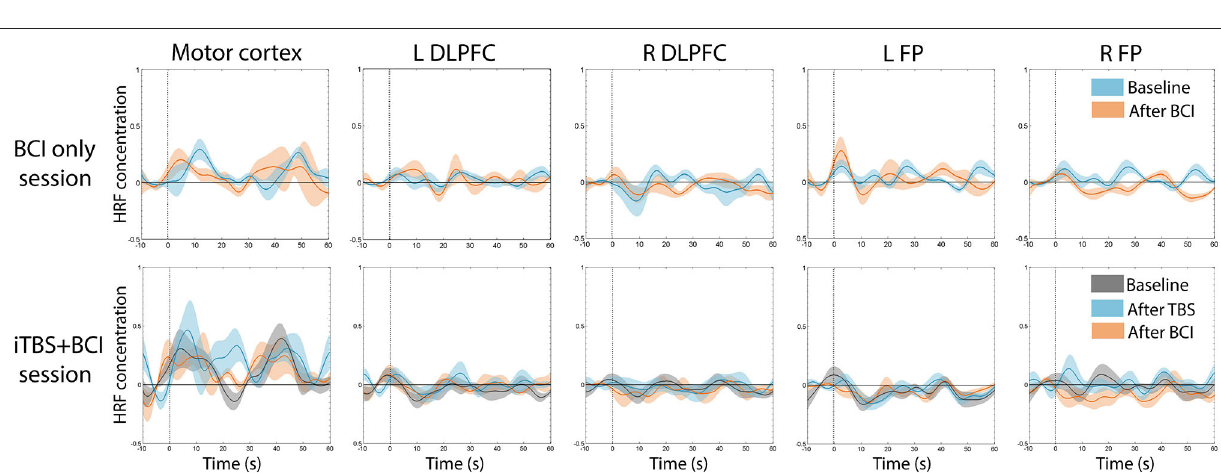
FIGURE 5 | Changes in TMS parameters after iTBS in two hemispheres. (A) In the left hand (i.e., the contralateral hand to iTBS), MEP rest and MEP active were significantly increased compared with baseline, and there was no significant change in CSP duration after iTBS. (B) In the right hand, there was no significant change in any TMS parameter after iTBS. *Indicates significant changes after iTBS.